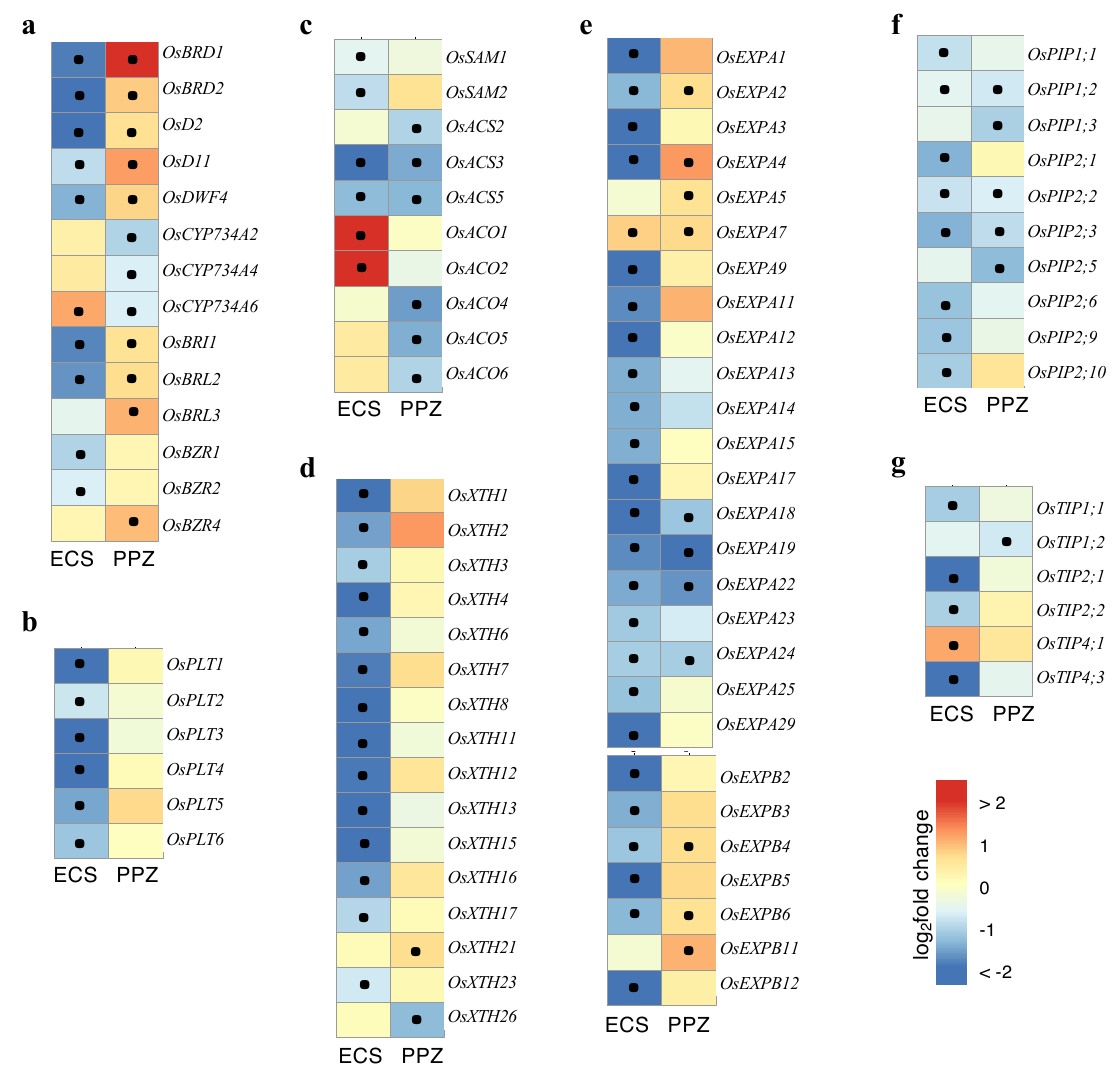
Figure 4. Expression of genes involved in BR biosynthesis and signaling, ethylene biosynthesis, cell proliferation and cell elongation. Heatmaps represent log2FC values of genes in the ECS vs. mock or PPZ vs. mock comparisons. Black dots indicate statistical significance of differential expression (adjusted p -value < 0.05). ( a ) BR biosynthetic and signaling genes, ( b ) OsPLT genes, ( c ) ethylene biosynthesis genes, ( d , e ) cell wall loosening and remodeling genes OsXTHs ( d ) and OsEXPs ( e ), ( f , g ) aquaporin genes OsPIPs ( f ) and OsTIPs ( g ). Only genes that showed statistical significance in at least one of the ECS or PPZ comparisons were included in this